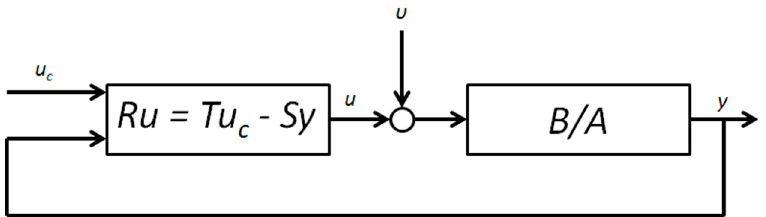
Figure 2 . Two-degree (feedforward and feedback) controller topology with commanded control u c and actual control u comprising coefficients R , T , and S , closely following development in [1].